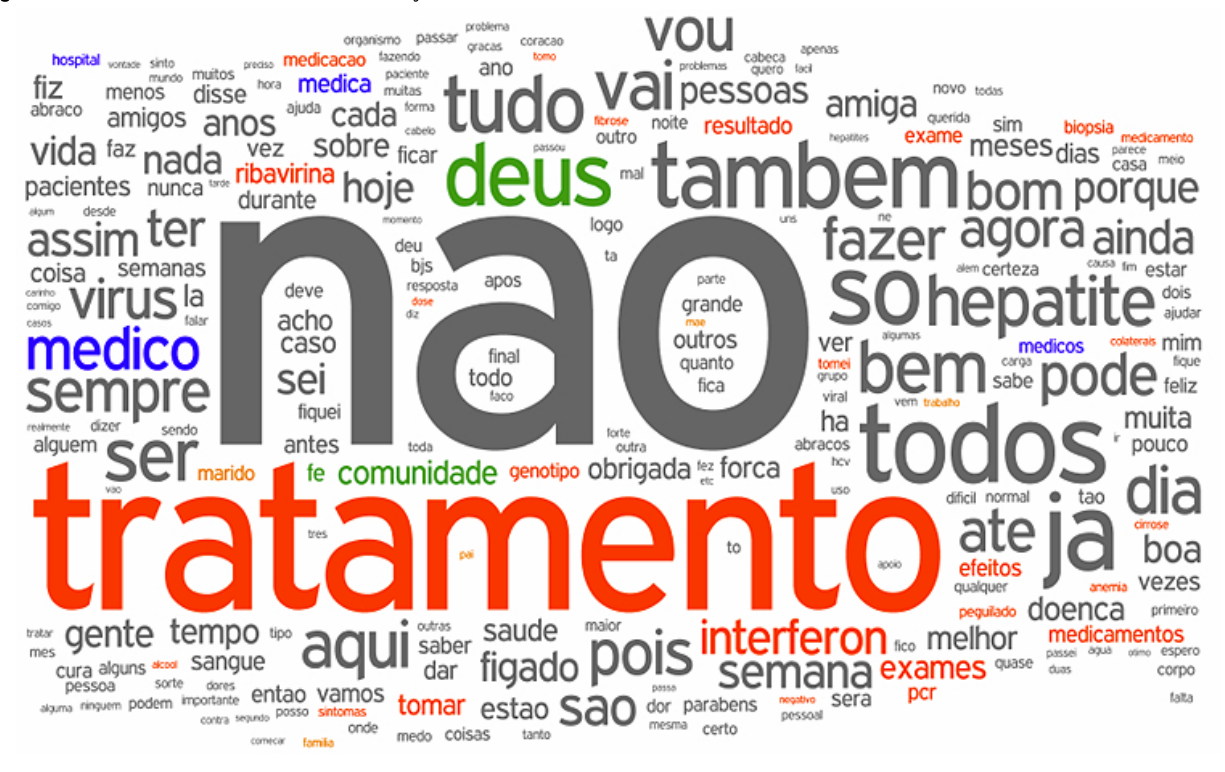
Figure 2. Word cloud of the Dominant Community